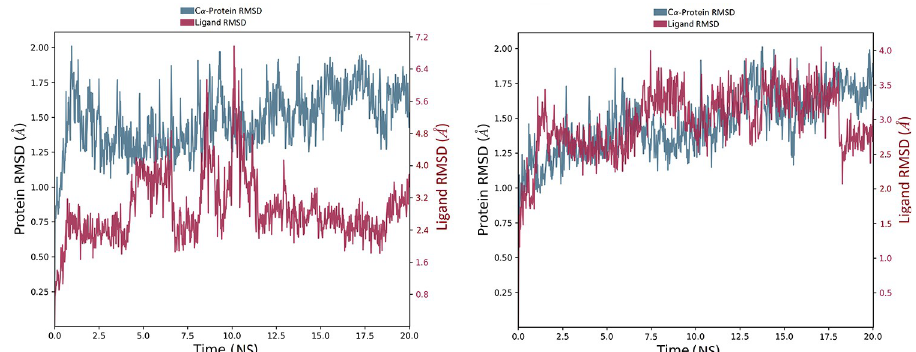
Fig 6. RMSD analysis of MD simulation trajectory. The RMSD plot obtained for (a) compound 2 -SARS-CoV-2 main protease complex (PDB ID 6LU7), and (b) compound 3 -SARS-CoV-2 main protease complex (PDB ID 6Y2F). The simulation time of 20 ns showing the formation of stable complex without any significant conformational changes in protein structure.